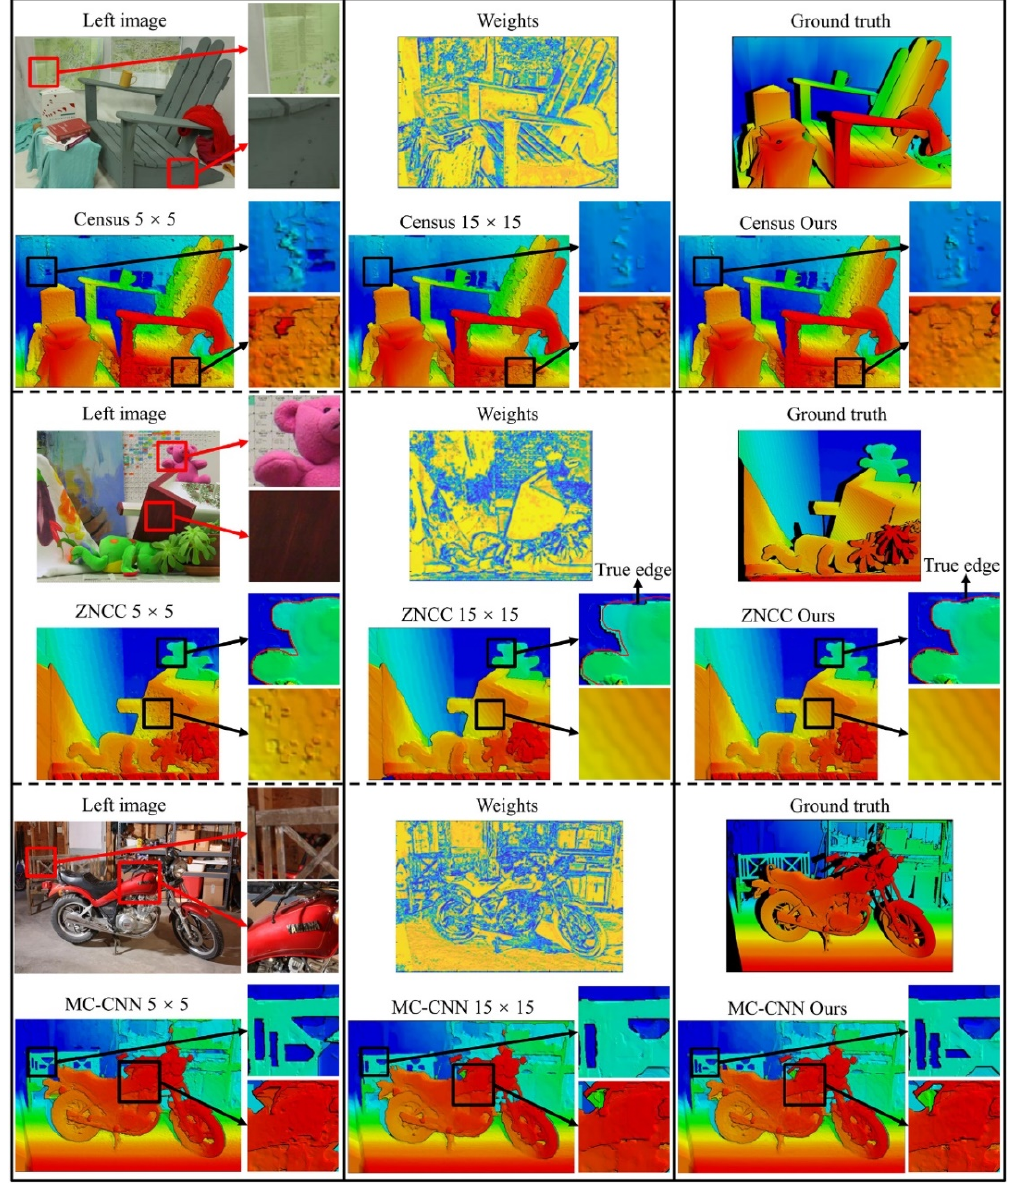
Figure 4. Examples of disparity images on the Middlebury dataset.